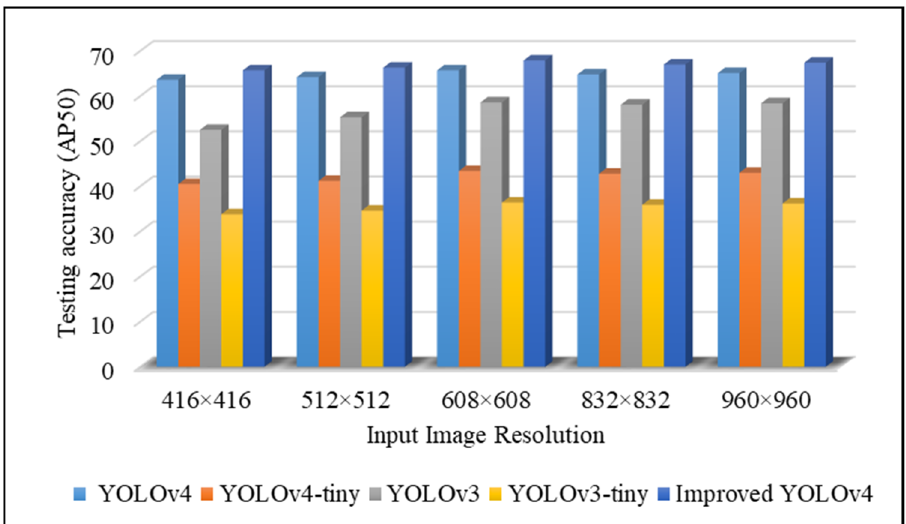
Figure 5. Performance of different systems at various input image resolution settings at testing stage with original images.